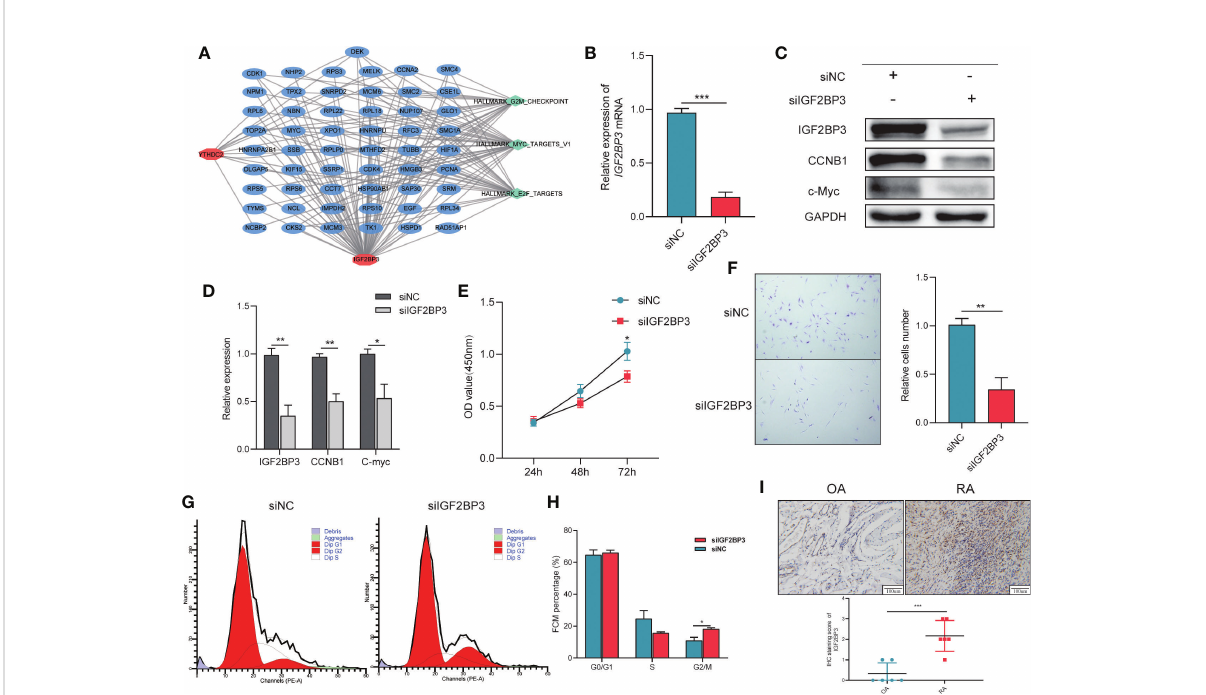
FIGURE 4 The importance of IGF2BP3 in the Viability and Cell Cycle of RA-FLSs. (A) The network connecting IGF2BP3 and YTHDC2 pathways and other targets; (B) RT − qPCR results showing the ef fi cient depletion of IGF2BP3 expression in RA-FLSs compared with siNC-transfected RA-FLSs; (C, D) Expression of IGF2BP3, c-MYC and CCNB1 in RA-FLSs after transfection; (E) The proliferative ability of RA-FLSs after transfection was evaluated by a CCK-8 assay; (F) Representative images (left) and histograms (right) showing the effect of siFN1 on the cell proliferation of RA-FLSs; (G, H) Flow cytometric analysis was used to evaluate the cell cycle distribution of RA-FLSs after transfection; (I) Representative IHC staining and IHC staining score of Synovial tissues. * p < 0.05, ** p < 0.01, *** p <